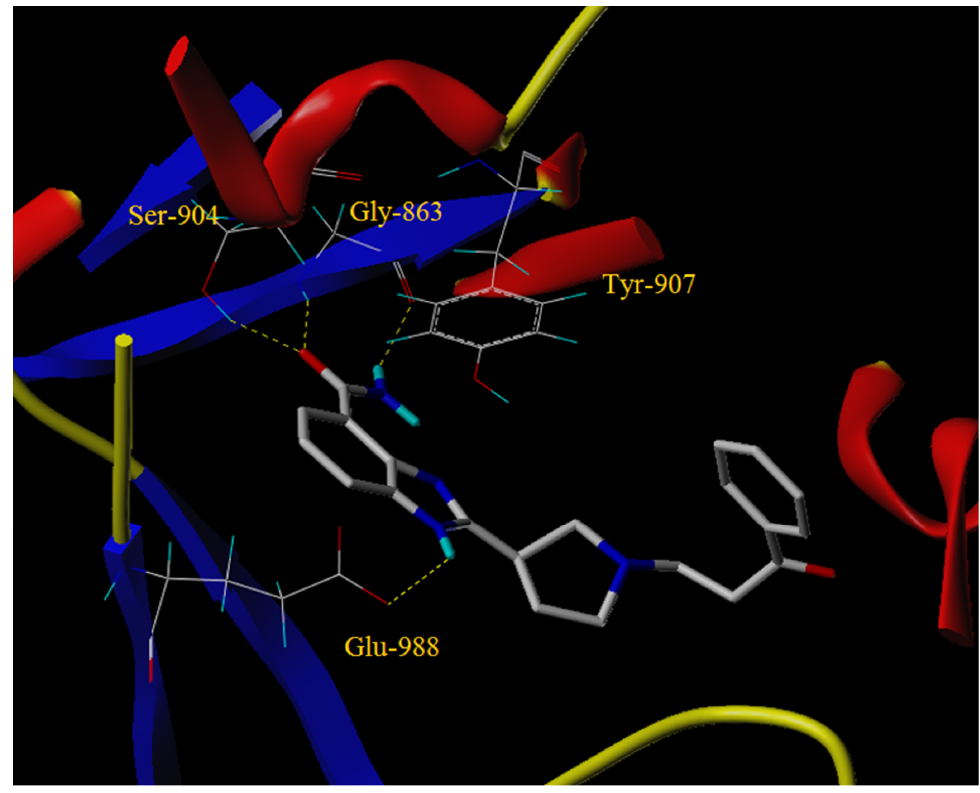
Figure 4. Molecular docking of 5cp with PARP-1.